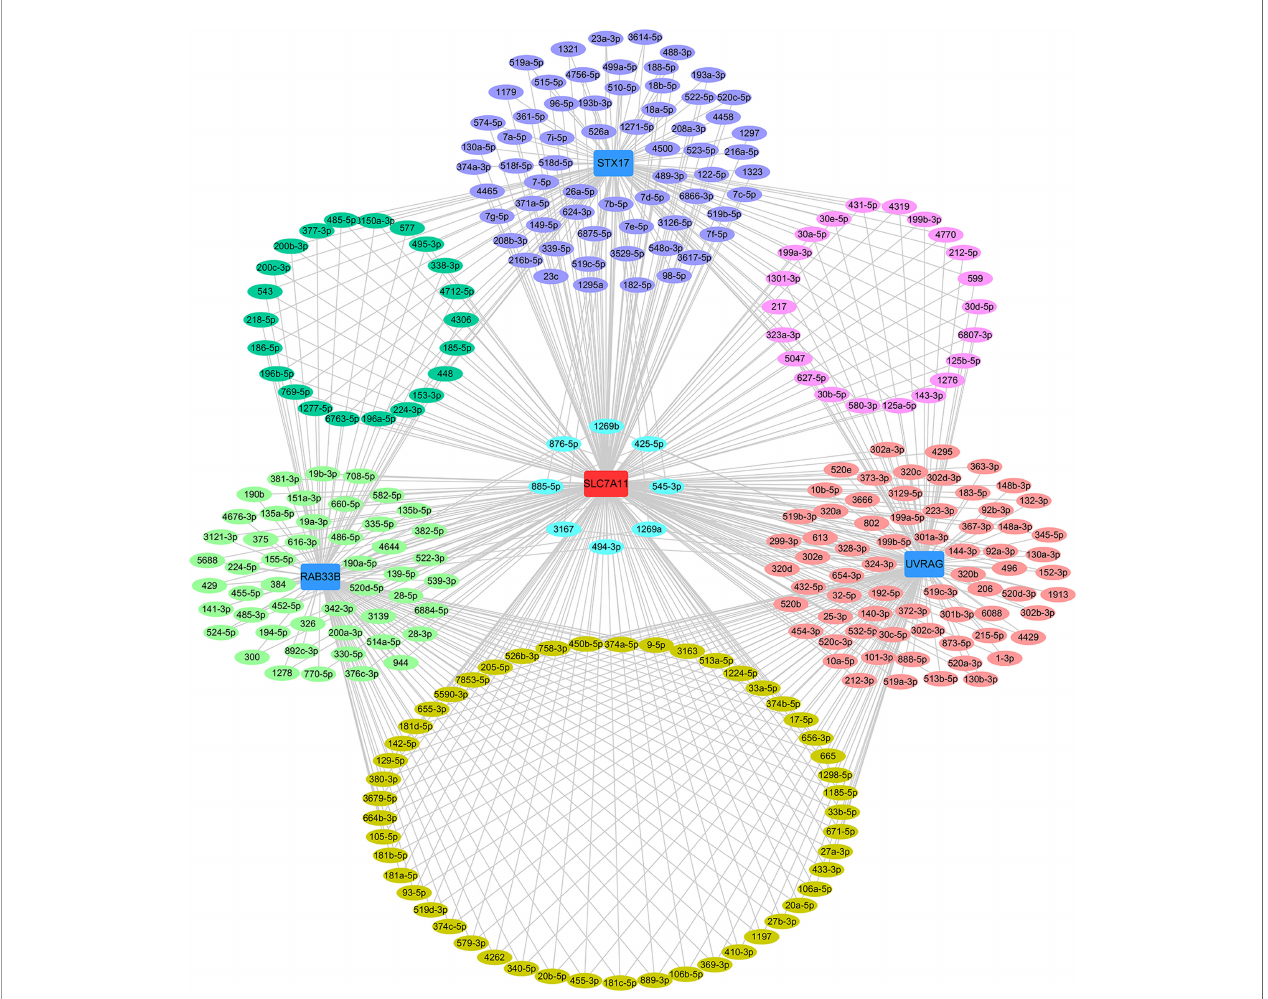
FIGURE 13 | ceRNA network of SLC7A11 with STX17, UVRAG and RAB33B. The ceRNA pairs were determined by StarBase and the network was constructed by Cytoscape. Acting as a ceRNA, SLC7A11 shared miRNAs with the target genes as indicated in the network. The light green oval indicate the miRNAs for SLC7A11 with RAB33B, the purple oval indicates the miRNAs for SLC7A11 with STX17, the rose-colored oval indicates the miRNAs for SLC7A11 with UVRAG, the green oval indicate the common miRNAs for SLC7A11 with RAB33B and STX17, the mauve oval indicates the common miRNAs for SLC7A11 with STX17 and UVRAG, the deep yellow oval indicates the common miRNAs for SLC7A11 with UVRAG and RAB33B, the sky-blue oval indicates the common miRNAs for SLC7A11 with STX17, UVRAG and